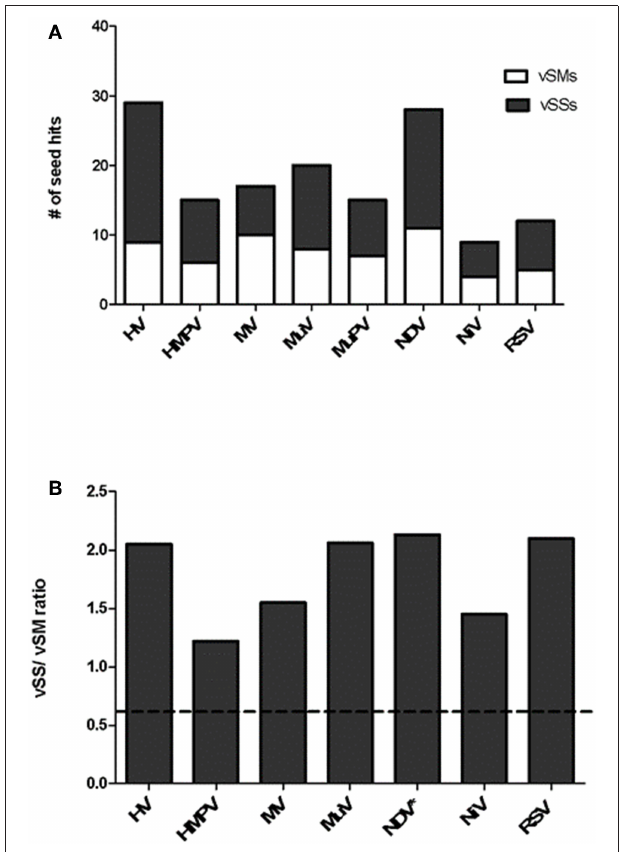
FIGURE 1 | Distribution of vSMs and vSSs across genera of the Paramyxoviridae family. (A) Viral sequences identical to host miRNA seed site were designated vSMs (open bars) while those complementary to miRNA seed sites were designated as vSSs (filled bars). (B) Ratio of vSS/vSM across genera is shown. Dotted line represents ratio equal to 1.0. HV, hendravirus; HMPV, human metapneumovirus; MV, measles virus; MuV, mumps virus; NDV, New Castle’s disease virus; NiV, nipah virus; RSV, respiratory syncytial